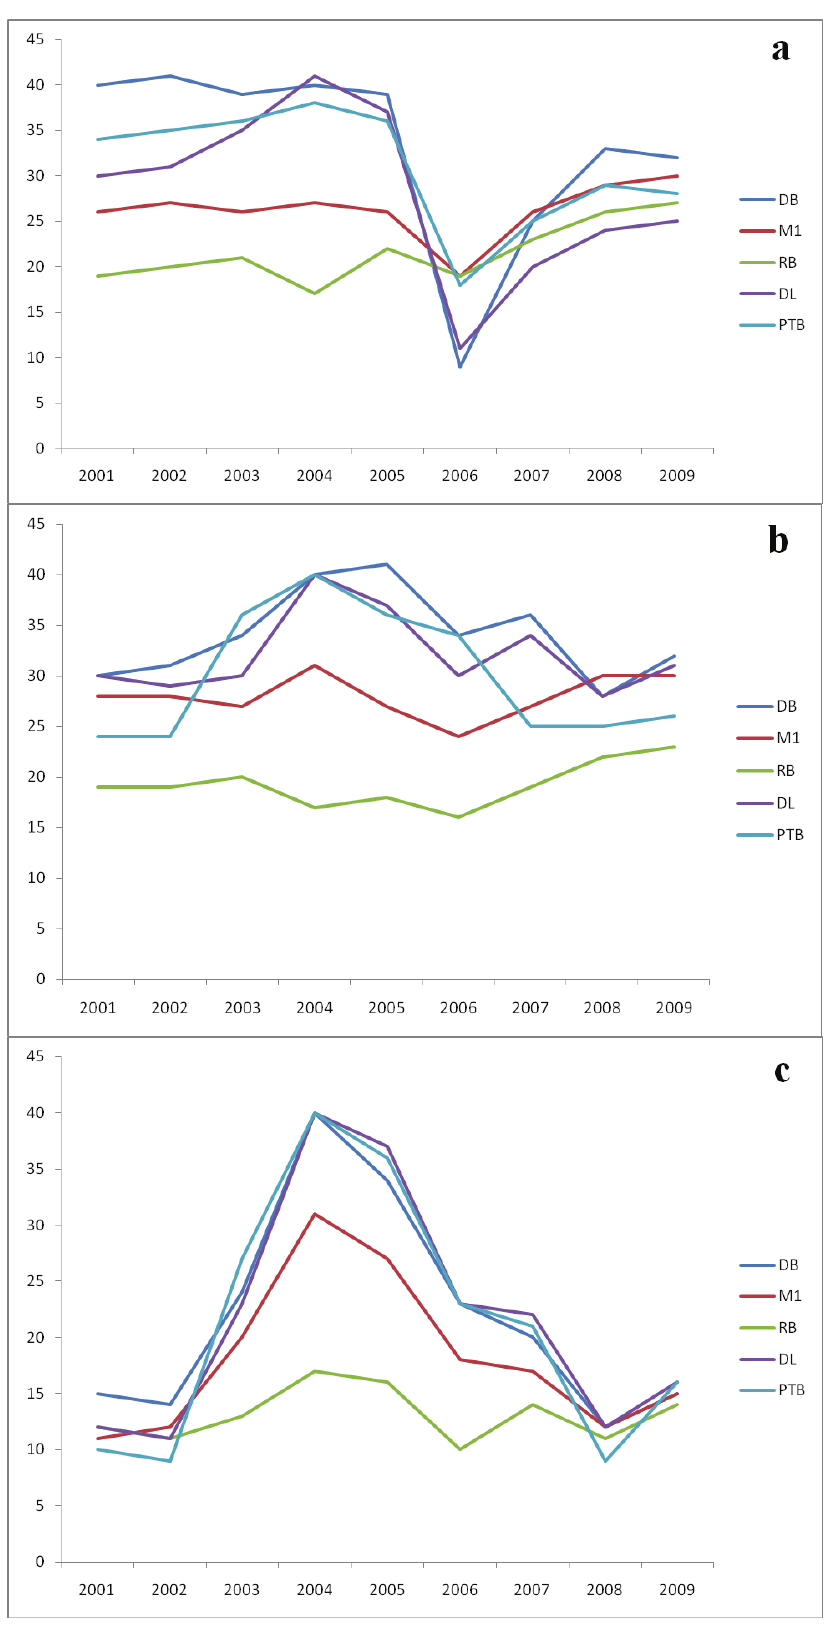
Figure 2. Graphs of annual changes in the colony numbers of small to medium-sized corals (0–500 mm 2 surface area) from 2001–2009 for (a), Sidastrea siderea ; (b), Porites astreoides and (c), Diploria strigosa at Rio Bueno (RB), M1 (M1), Dancing Ladies (DL), Dairy Bull (DB), and Pear Tree Bottom